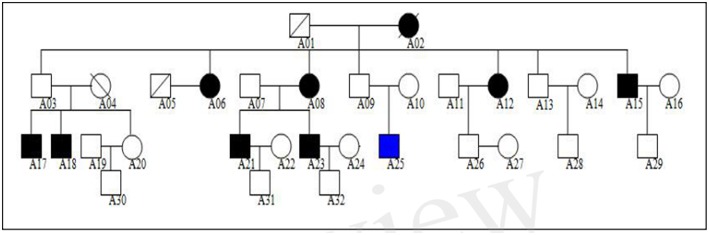
Northern Chinese family of ethnic Han origin in which 9 individuals (5 males and 4 females) affected with MDD or BD. The proband of this pedigree was A21, who was diagnosed with BD. None of these individuals displayed atypical findings on neurological examination, but one of them (A25) had mild intellectual disability since childhood.